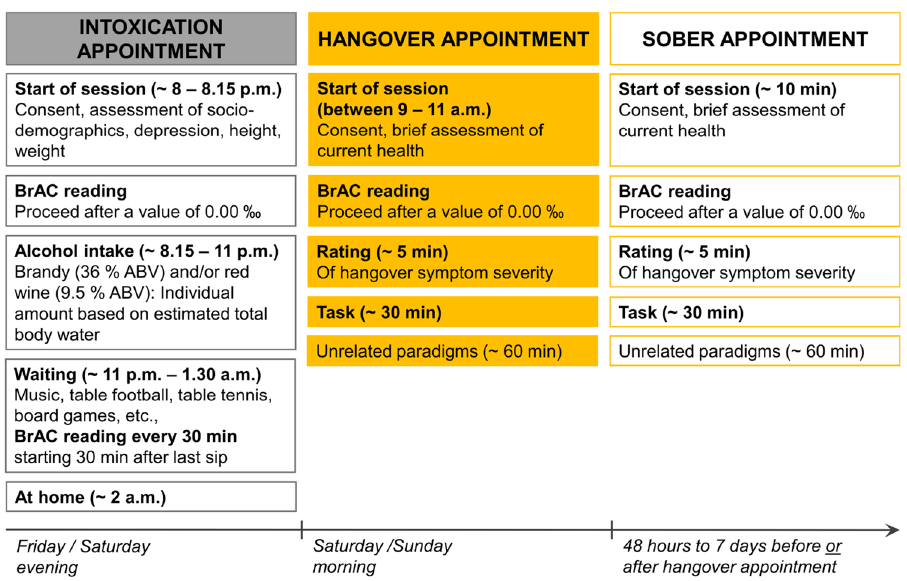
Figure 7. Visualization of the experimental procedure in the hangover group. Each participant was tested once hungover after a night of being experimentally intoxicated at our facilities and once sober. Appointment order was balanced across the